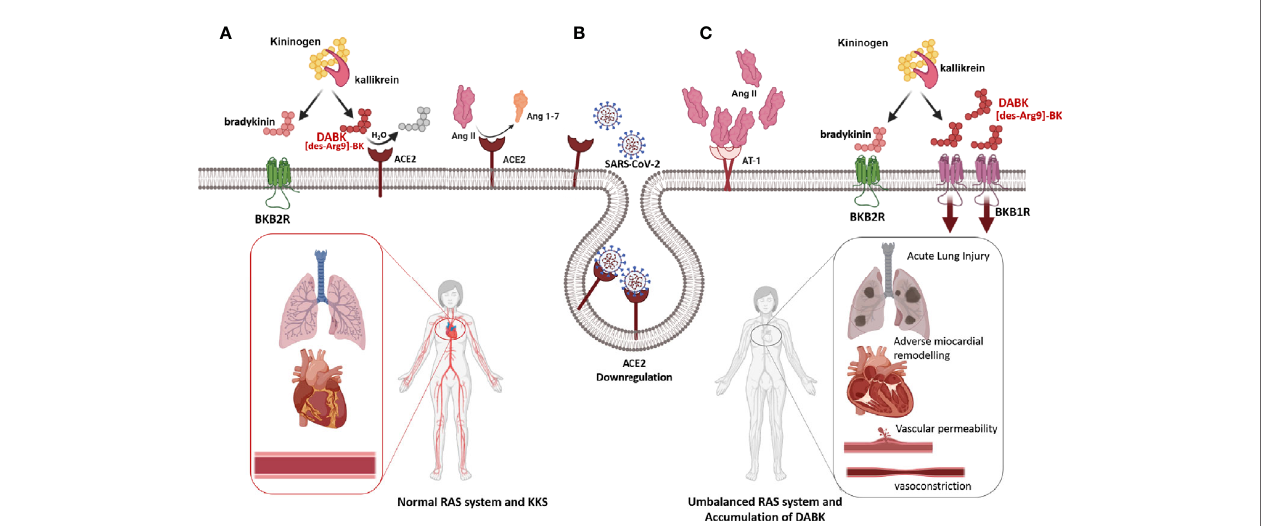
FIGURE 4 | Depletion of ACE2 after SARS-CoV-2 infection (A) Under physiological conditions, the RAS allows the harmonic functioning of the cardiorespiratory system, and even the peripheral vascular tone. Under these conditions, the relationship between RAS and Kinin Kallicrein System (KKS) consists of that ACE2 hydrolyzes and inactivates the most active metabolite of bradykinin, DABK, and prevents its signaling through the BKB1R receptor. (B) The infection with SARS-CoV-2 produces ACE2 depletion because the SARS-CoV-2-ACE2 complex is internalized into the cytoplasm. (C) Depletion of ACE2 produces an increase in its substrates, Ang II, and DABK. The concerted action of Ang II and DABK through signaling induced by their cognate receptors, AT 1 R and BKB1R, respectively, produces an in fl ammatory state, together with vascular permeability, vasoconstriction, recruitment of in fl ammatory cells, and pulmonary and systemic damage (125,